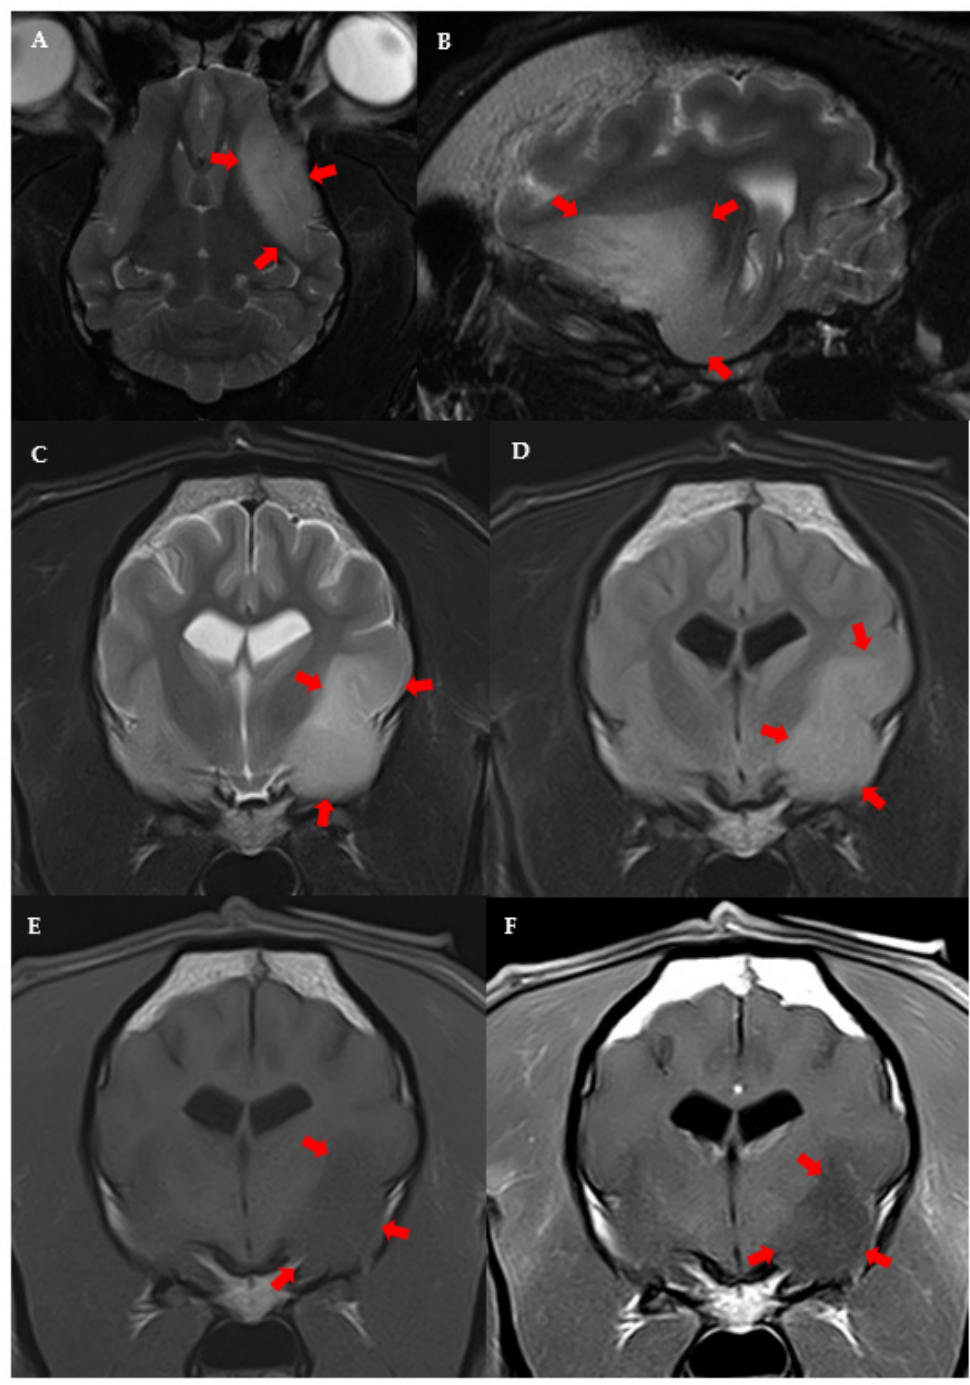
Figure 4. MRI images of suspected low-grade glioma in the left piriform lobe of a 9 year-old male French Bulldog. Dorsal ( A ) and left parasagittal ( B ), T2-w. Transverse T2-w ( C ), T2-FLAIR ( D ), T1-w ( E ), and T1 post-contrast ( F ). The left side of the patient is on the right side of the image.